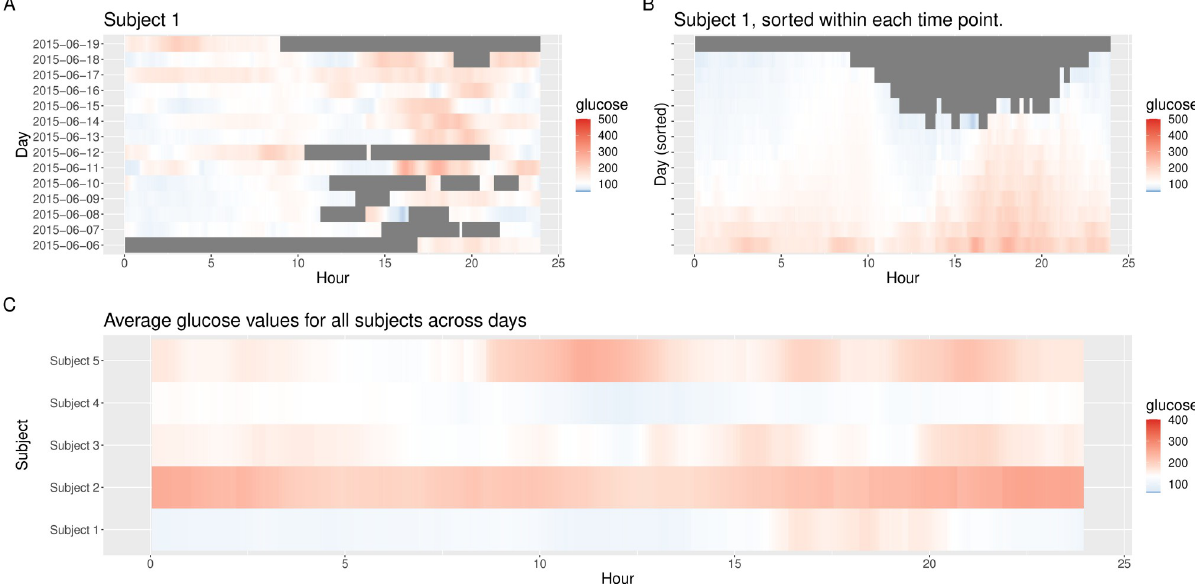
Fig 2. Lasagna plots. (A) unsorted and (B) time-sorted lasagna plot for Subject 1; (C) unsorted customized multi-subject lasagna plot based on average values across days.